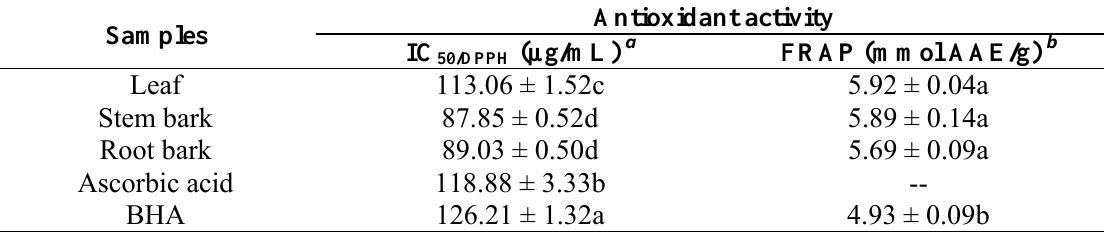
Table 3. Antioxidant activities of the condensed tannins from different parts of A. confusa using the (DPPH) free radical scavenging assay and the (FRAP) ferric reducing antioxidant